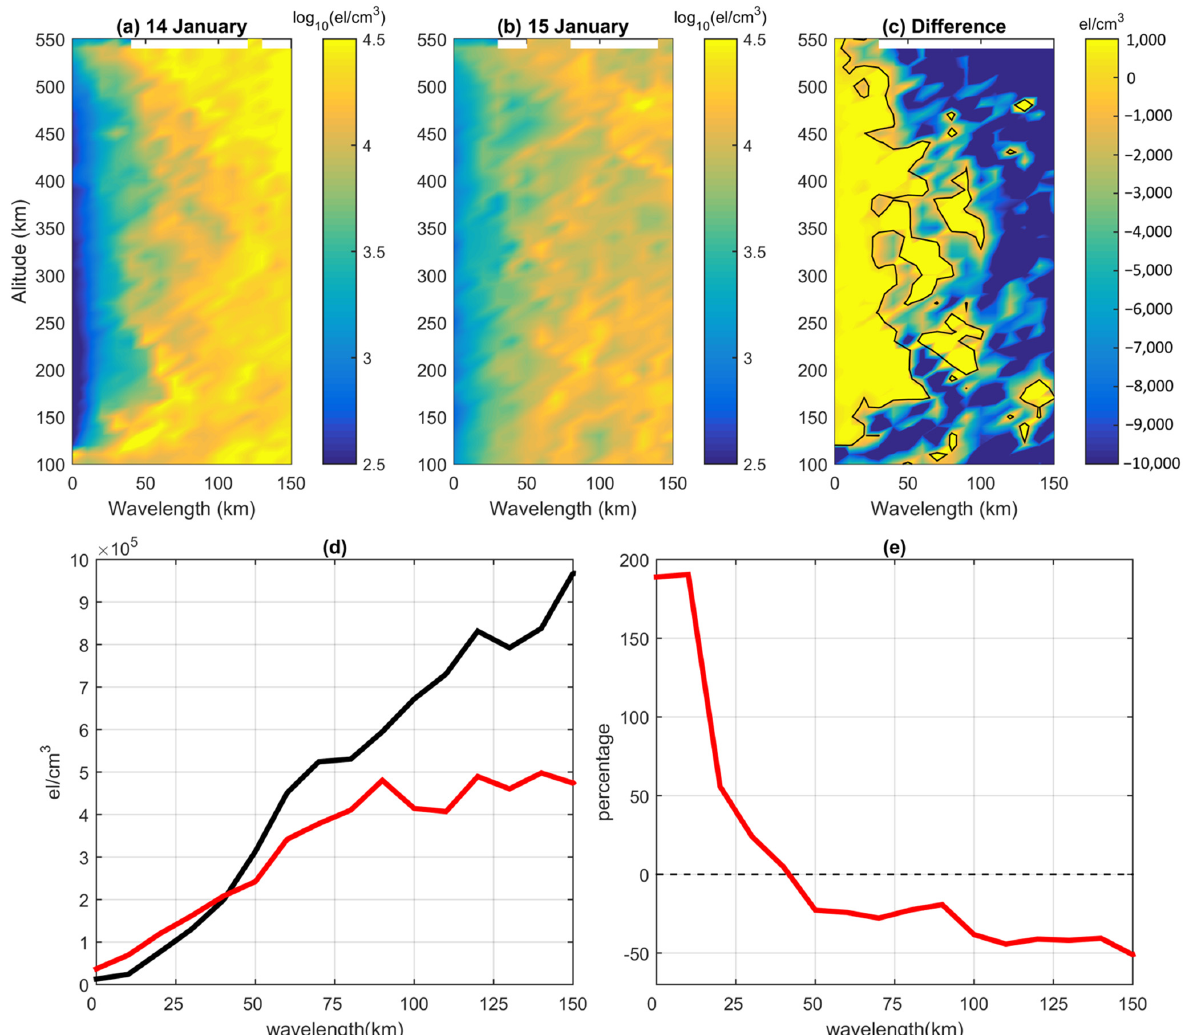
Figure 4. Hilbert spectra of Ne profiles from 04:15 UT to 10:00 UT on ( a ) 14 and ( b ) 15 January (eruption day). ( c ) Difference between the spectra on the eruption day and one day before. The contour line sketched the value of 0 el/cm 3 . ( d ) The black and red curves are the marginal spectra on 14 ( 𝑛 (cid:3041)(cid:3042)(cid:3045)(cid:3040)(cid:3028)(cid:3039) ) and 15 January ( 𝑛 (cid:3032)(cid:3045)(cid:3048)(cid:3043)(cid:3047)(cid:3036)(cid:3042)(cid:3041) ), respectively. ( e ) Relative difference between the marginal spectra that is defined as (cid:4666)𝑛 (cid:3032)(cid:3045)(cid:3048)(cid:3043)(cid:3047)(cid:3036)(cid:3042)(cid:3041) (cid:3398) 𝑛 (cid:3041)(cid:3042)(cid:3045)(cid:3040)(cid:3028)(cid:3039) (cid:4667) / 𝑛 (cid:3041)(cid:3042)(cid:3045)(cid:3040)(cid:3028)(cid:3039) . The amplitude during the period between 10:00 UT to 16:00 UT on 14 January (Figure